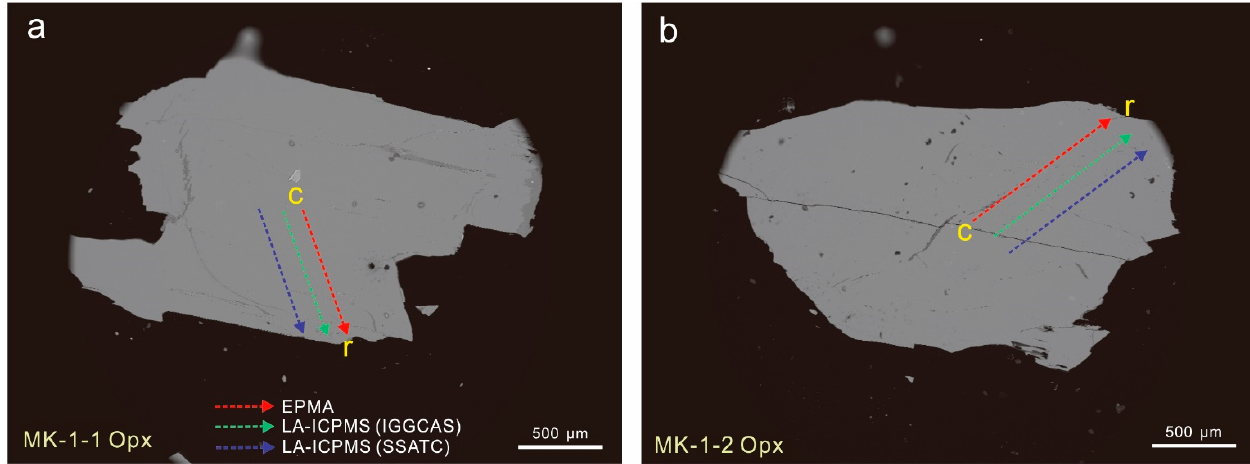
Figure 1. Representative backscatter electron (BSE) images of MK-1 orthopyroxene. ( a ), MK-1-1; ( b ), MK-1-2. The red lines show the core-to-rim profiles of EPMA analyzed spots, the green lines represent LA-ICPMS analyzed spots obtained from IGGCAS, and the purple lines represent LA-ICPMS analyzed spots obtained from SSATC.